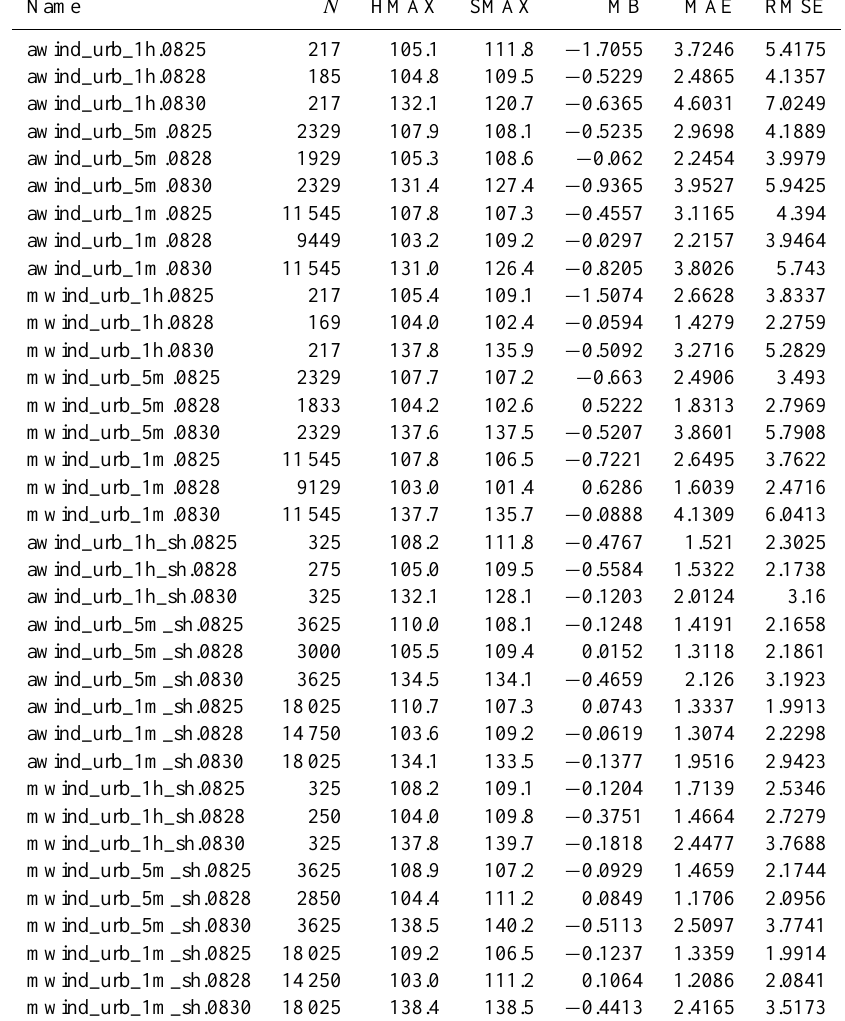
Table 3. Summary of statistical parameters for STOPS–CMAQ concentrations, when STOPS was used in the moving mode, with the starting position in the urban